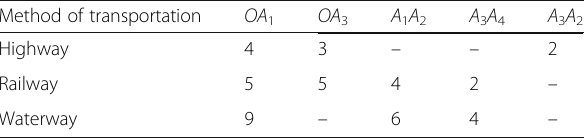
Table 1 Transport time parameters of each node Method of